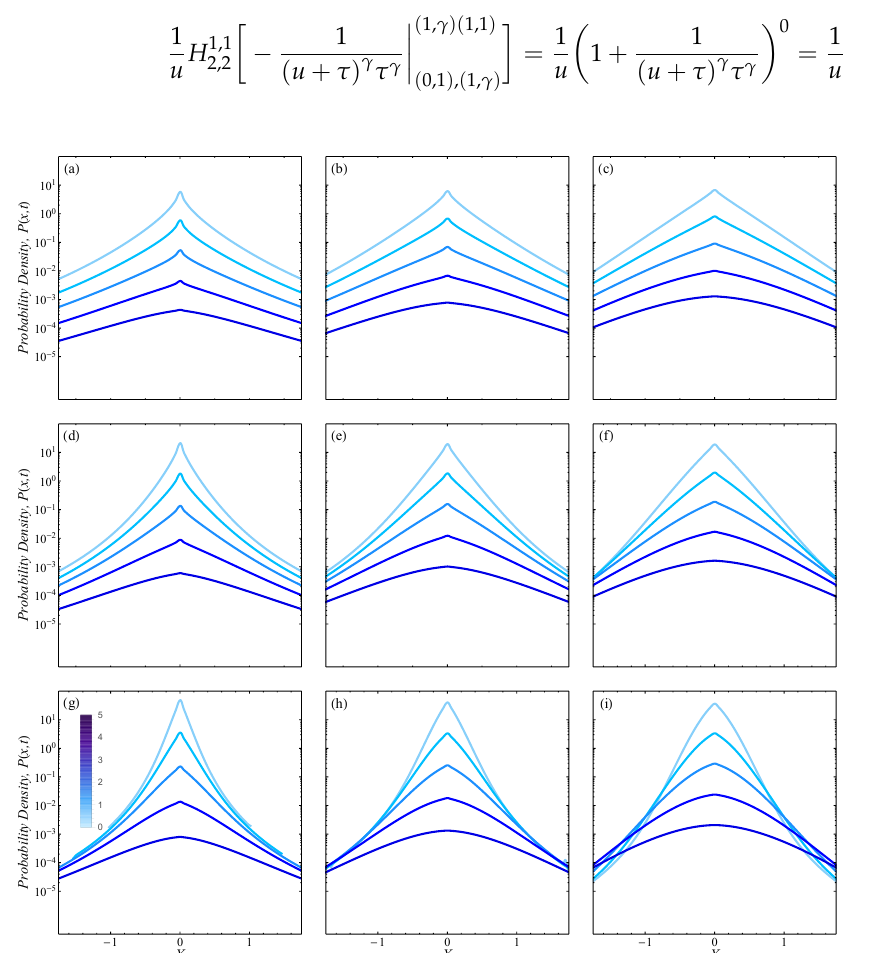
Figure 1. Position probability density functions corresponding to increasing values of γ and µ in Equation (29), where X is dimensionless, X = x / σ . The value of γ ranges from γ = 1/4 (first row), to γ = 3/4 (third row), in increments of 1/4 and µ ranges from 3/2 (first column) to 5/2 (third column) in increments of 1/2. The colours correspond to units of time, t / τ , within the open range ( 0,5 ) (light blue to dark blue). These figures have used the values of τ and σ to be τ = σ =